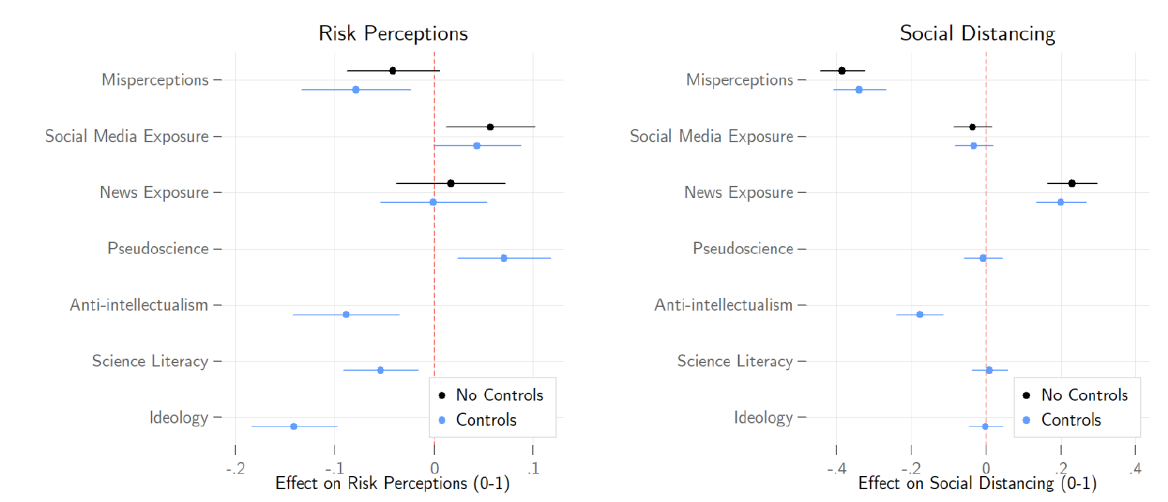
Figure 3. Effects of COVID-19 Misperceptions on Risk Perceptions (Left) and Social Distancing (Right). Figure 3 plots the coefficients from Ordinary Least Squares regression models. Left panel plots the effects of misperceptions on COVID-19 risk perceptions with and without science literacy and predispositions as controls. Right panel does the same for social distancing. All measures scaled from 0-1, so effects can be interpreted as going from the minimum to the maximum of explanatory variables on the 0-1 scales of each outcome. Additional controls for online and offline discussion, income, education, age, gender, religiosity, language, and region not plotted. 95% confidence intervals